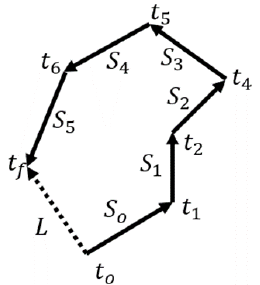
Figure 6. Sketch of the definitions of the wind run ( S i ) and of the transport distance ( L ). Each segment S i is computed using an average over the time interval T equal to 15 min. Note that the end of each arrow in the figure corresponds to a time, not a point in space. Adapted from